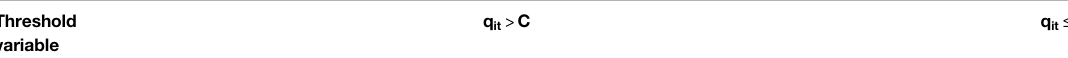
TABLE 5 | Number of provinces in different threshold intervals in